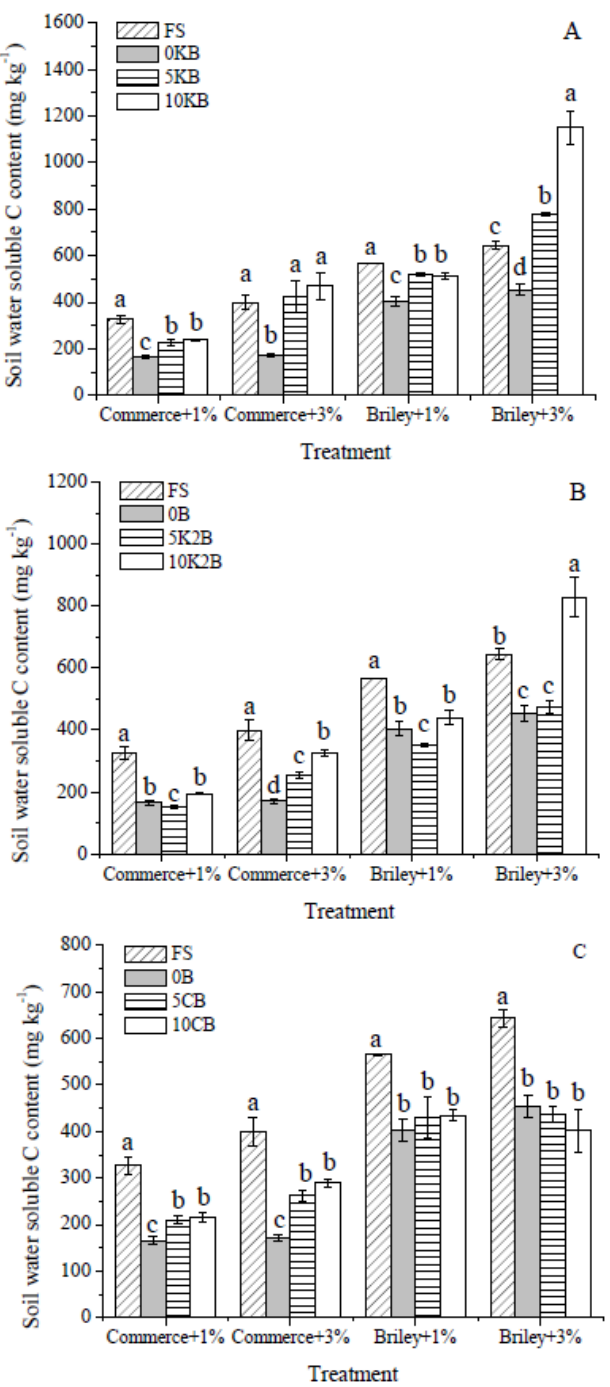
Figure 4. Water soluble C content of Si source amendments at application rates of 1 and 3% in Commerce and Briley silt loam soil. Note: In the figure, subgraph ( A – C ) indicates KOH, K 2 CO 3 , and CaO of alkali treatments, respectively. FS, rice straw feedstock; 0B, 5KB/K2B/CB, 10KB/K2B/CB indicate the biochars prepared at the proportion of KOH/K 2 CO 3 /CaO to feedstock of 0:100, 5:100, and 10:100. Different letters indicate significant differences within treatment ( p < 0.05) based on Duncan’s multiple range test.